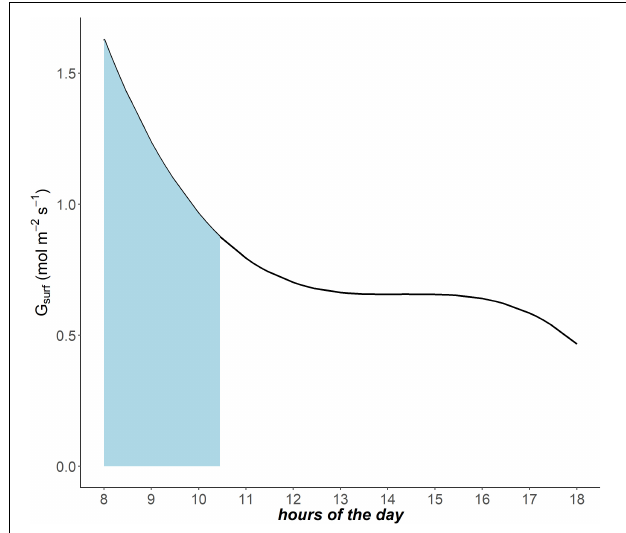
FIGURE 1 | Example of daily pattern of canopy conductance G surf (mol m - 2 s - 1 ) in site I1 day of the year 175 (i.e., Italy 24th June). The light blue area underlies the time interval in which vapor pressure deficit (VPD) 80